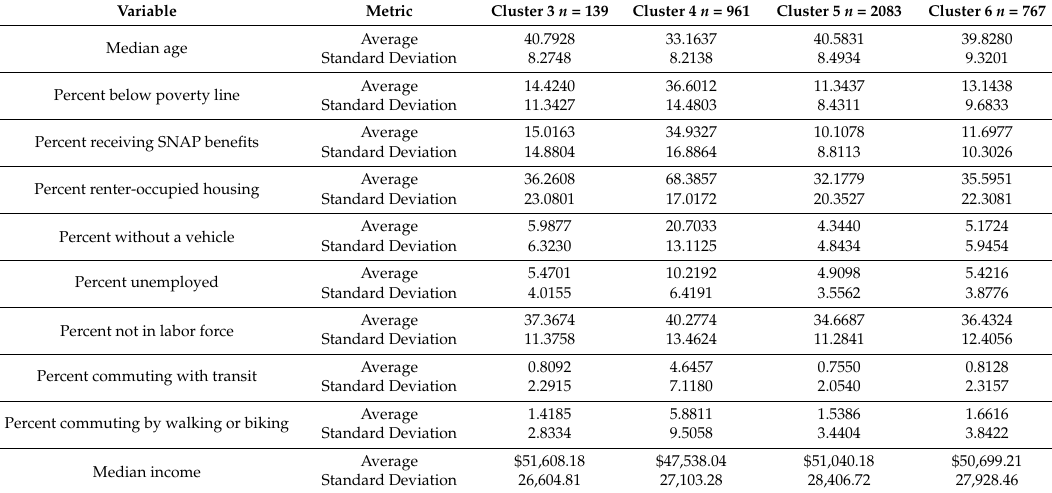
Table 3. Average and standard deviation of variables belonging to four urban